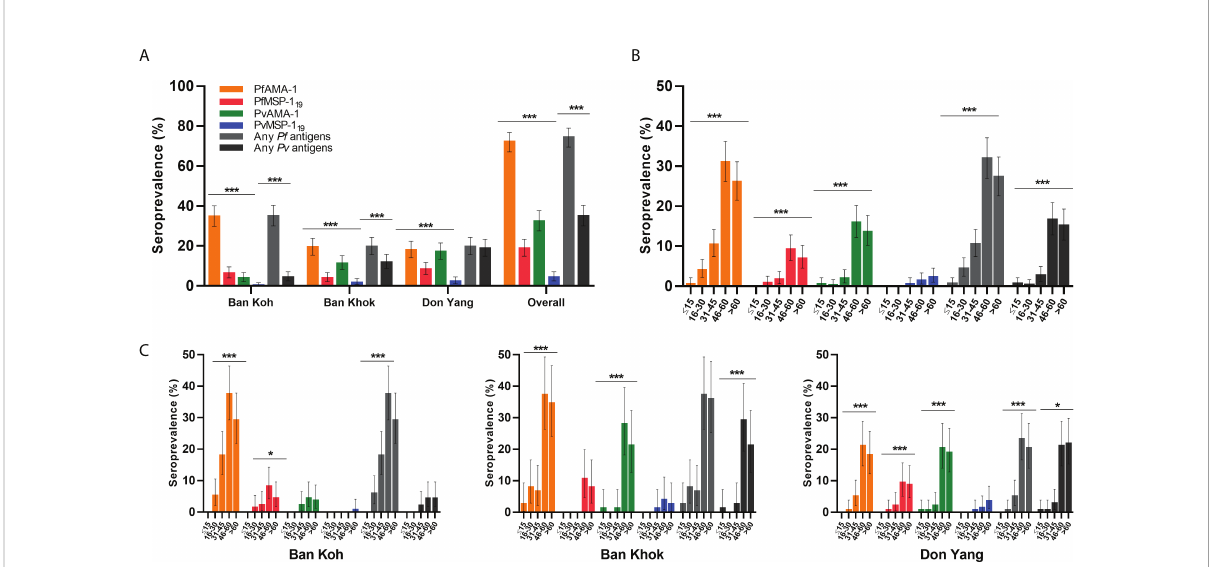
FIGURE 2 Speci fi c seroprevalence of P. falciparum (PfAMA-1 and PfMSP-1 19 ) and P. vivax (PvAMA-1 and PvMSP-1 19 ) by the study area and age group. (A) Area-speci fi c seroprevalence of participants by the study area. (B) Overall age-speci fi c seroprevalence of participants and (C) age-speci fi c seroprevalence of the study area. Seroprevalence is de fi ned as the proportion of seropositive individuals in the study population based on a speci fi c cutoff value generated for each recombinant antigen. Differences between the groups were determined using the Chi-square test or